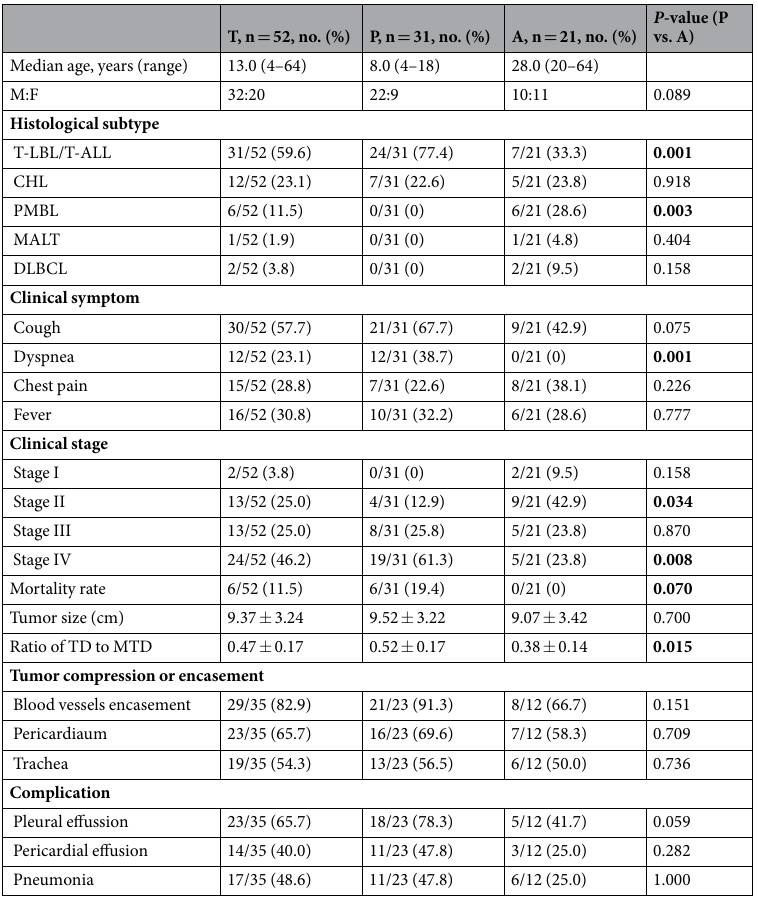
Table 2. Comparisons of histological subtypes, clinical features, and radiological findings between pediatric and adult patients. Abbreviations: T, total; P, pediatric patients; A, adult patients; TD, tumor diameter; MTD, maximum transthoracic